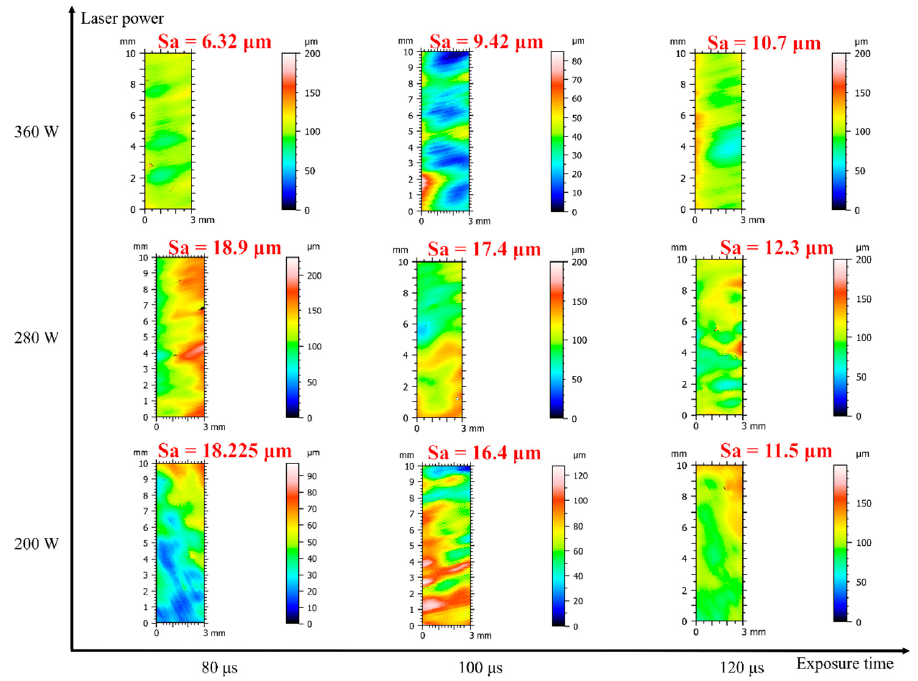
Figure 9. The surface roughness of the specimen under different parameters of 50 µ m layer thickness.